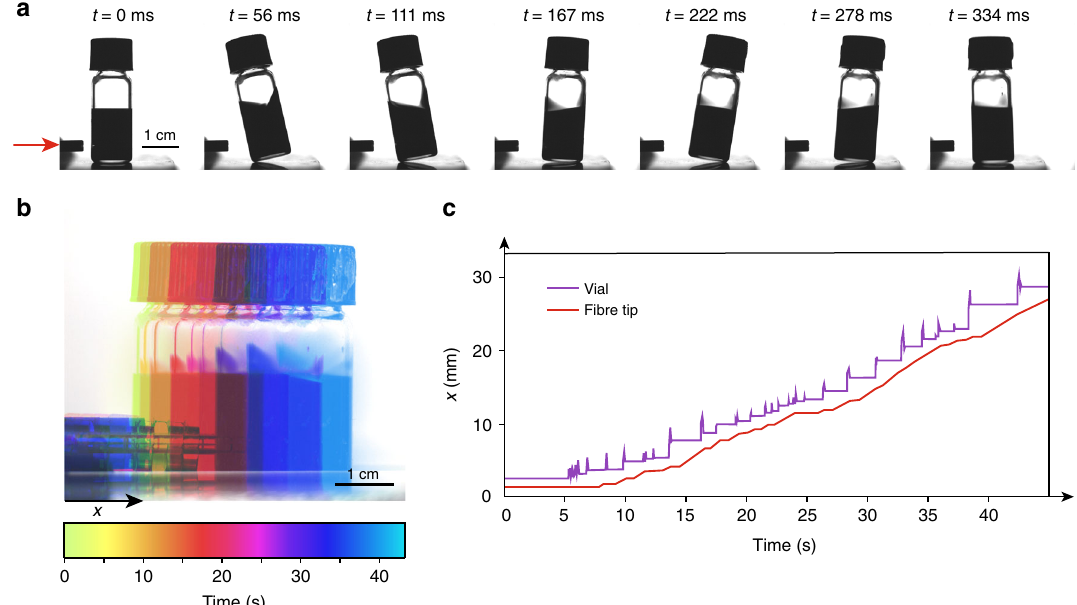
Fig. 1 A vial fi lled with a lead sul fi de nanoparticle solution is propelled by a near-infrared laser. a Snapshots of the vial motion during one laser-induced jump. The red arrow indicates the propagation direction of the laser. b Temporal colour-code projection of the large-scale vial motion obtained when the fi bre tip is kept at an approximately constant distance from the vial. The image is a superposition of ten snapshots of the vial motion, with the colour encoding time. c Vial and fi bre tip position as a function of time corresponding to the large-scale motion shown in b